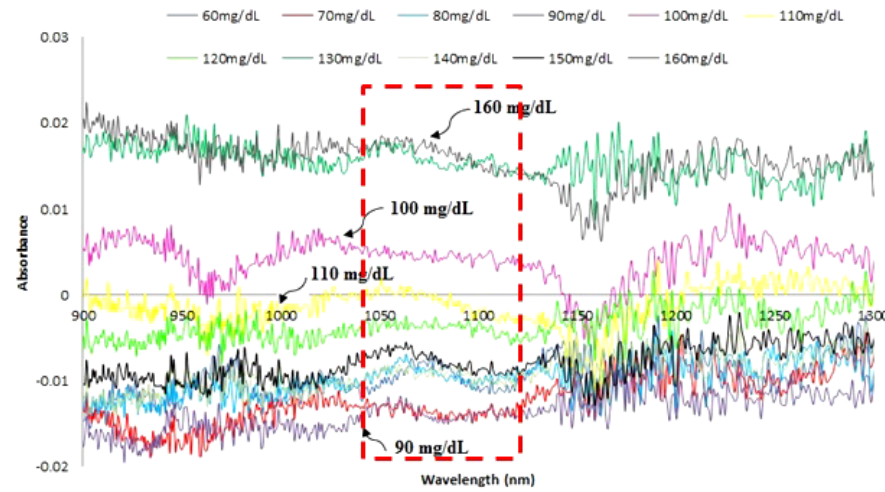
Fig. 5. Absorbance spectrum for tungsten halogen with glucose concentration range 60 to 160